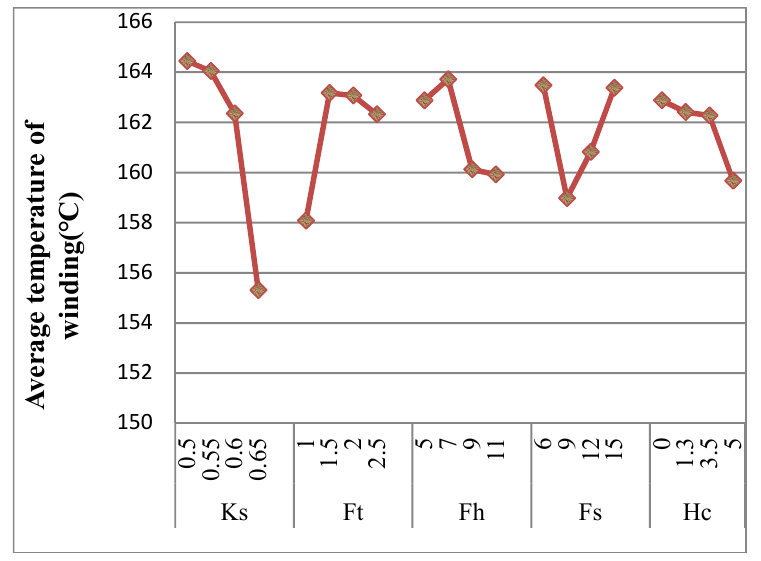
Figure 5 The effect of the main factors on the average temperature of winding.